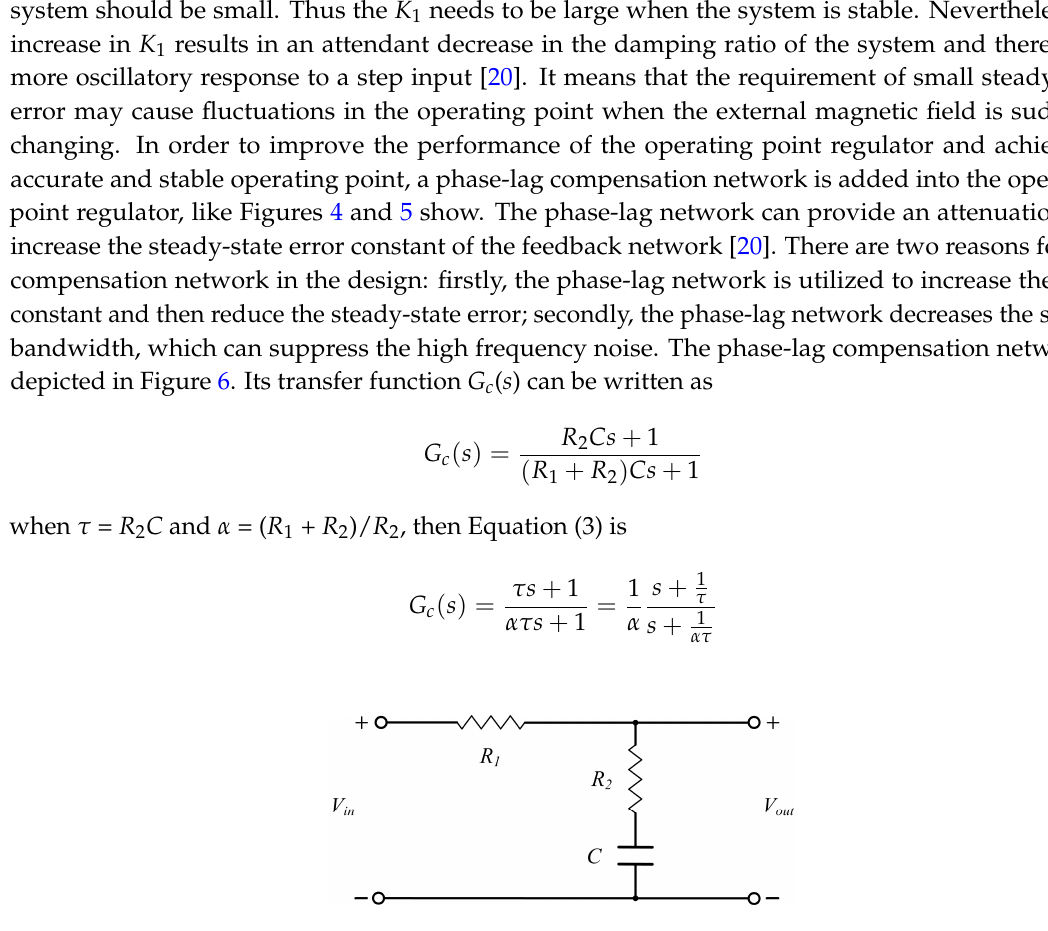
Figure 5. The block diagram model of the operating point feedback control.